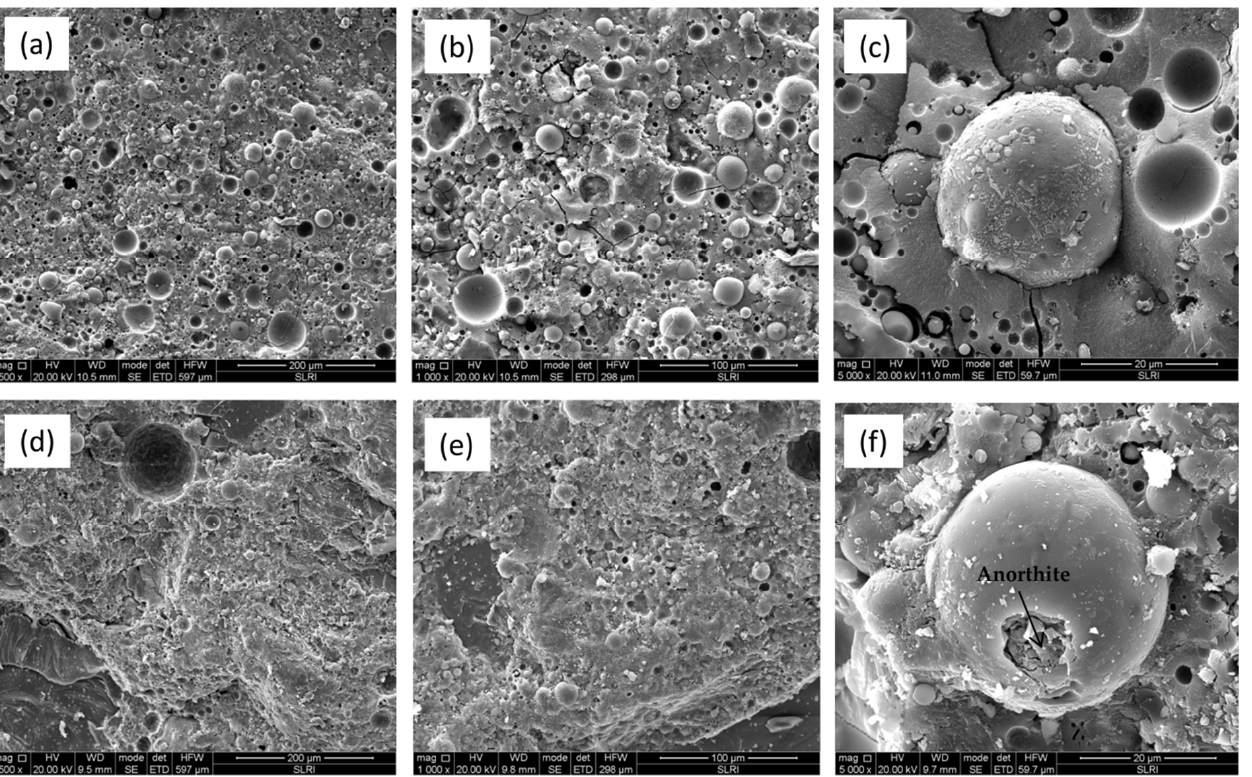
Figure 2. SEM micrograph of fly ash geopolymer at different curing age; 28 days with various magnification: ( a ) 500×; ( b ) 1000×; ( c ) 5000×; and 10 years: ( d ) 500×; ( e ) 1000×; ( f ) 5000× .